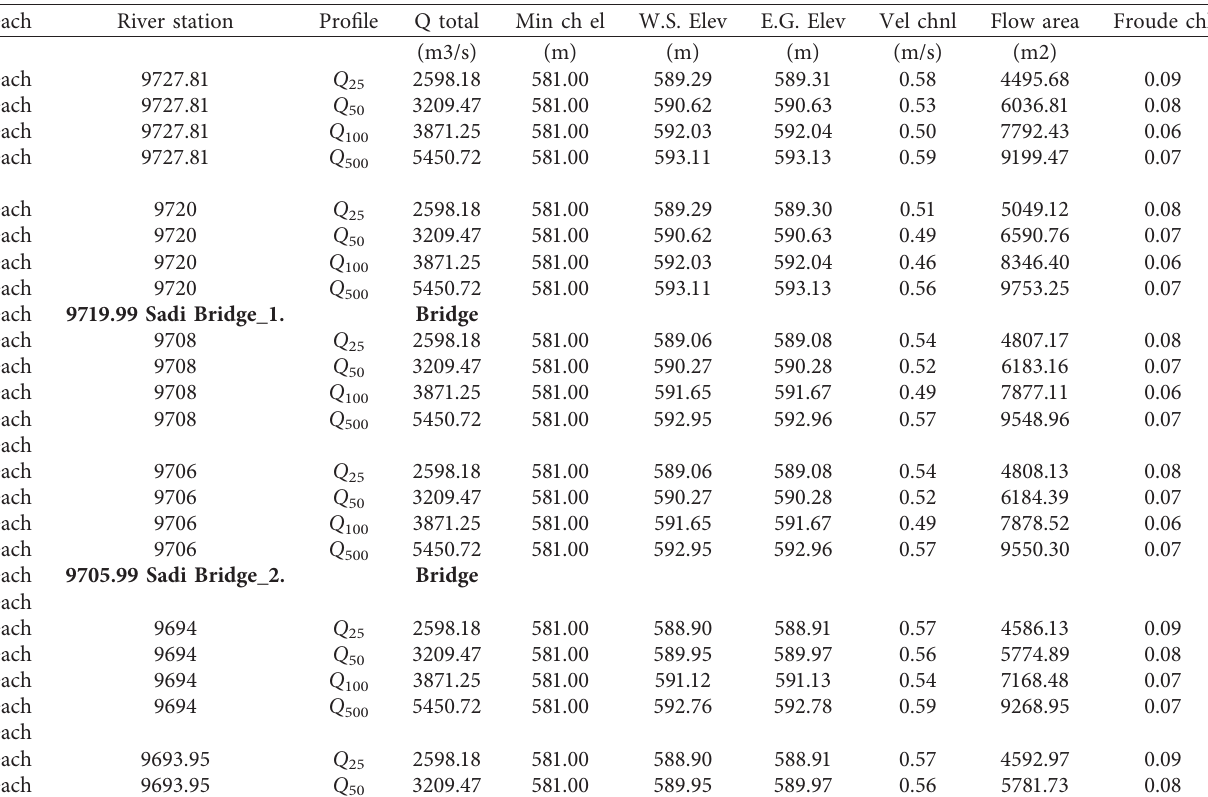
Figure 12: General profile plot Table 3: Profile output tables of the Tigris River (partially).